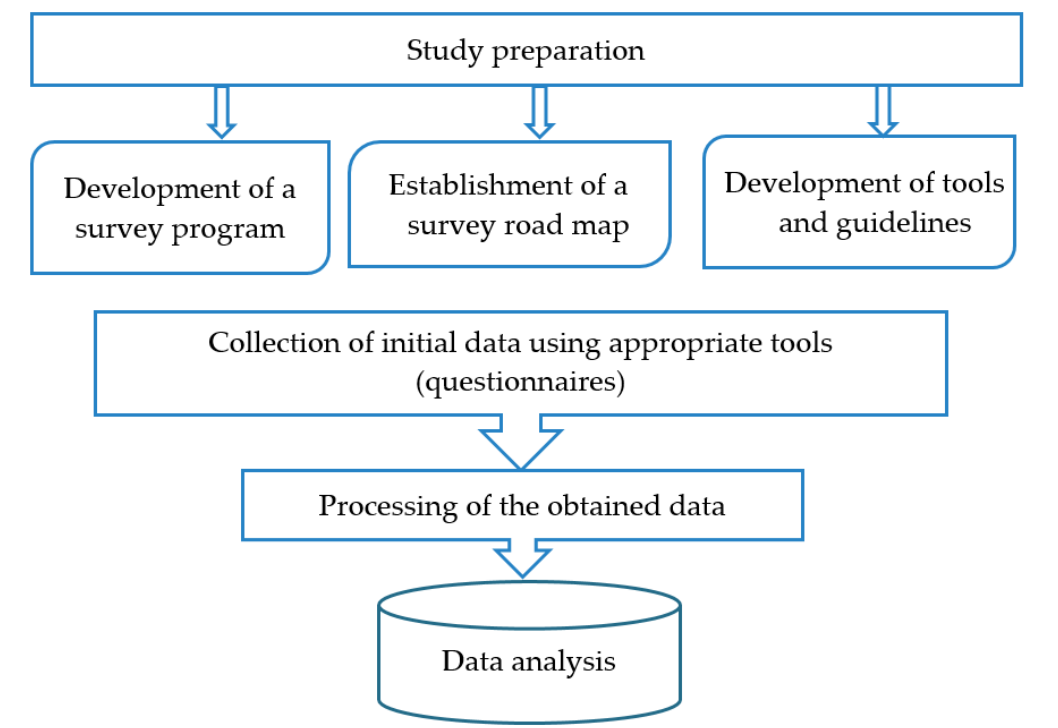
Figure 5. Design of offline sociological survey.